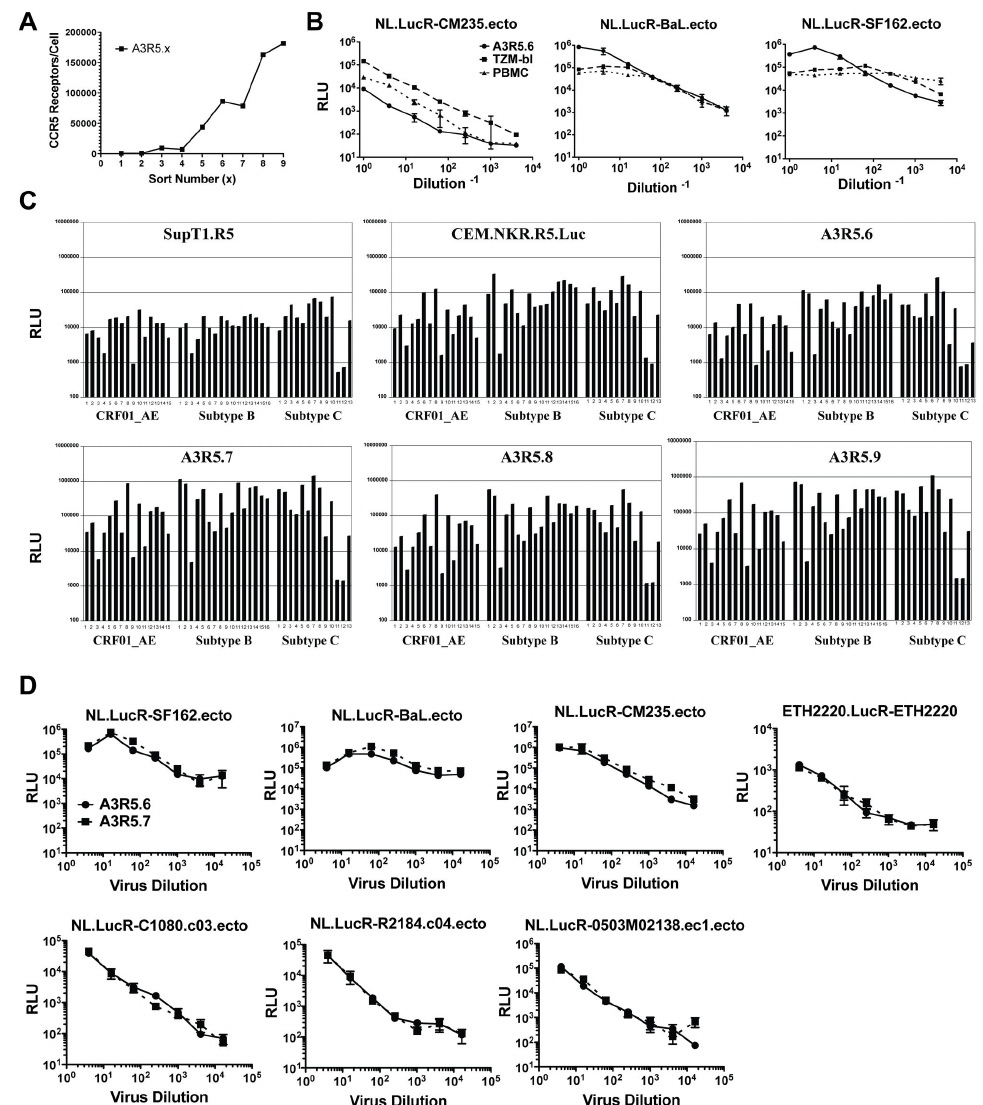
Figure 1. Initial characterization of A3R5 cell lines. A. CCR5 surface receptor number in sequentially sorted A3R5 cell lines. For each sort, 2.0 x 10 7 cells were subjected to fluorescence activated cell sorting with the brightest population (top 25%) selected for expansion. Receptor number was calculated using Simply Cellular Beads. In general, each successive sort resulted in increasing CCR5 intensity on the cell surface. B. Titration of NL.LucR-env.ecto in A3R5.6, TZM-bl and PHA/IL2 PBMC. Replication competent reporter viruses encoding subtype B env (NL-LucR.T2A-SF162.ecto, NL-LucR.T2A-BaL.ecto) and subtype AE env (NL-LucR.T2A-CM235.ecto) were titered in each target cell. Background luciferase activity (cell control wells) was subtracted prior to plotting. The data show similar virus growth in the three target cells. C. Infectivity of IMC.LucR viruses from multiple subtypes in various CCR5-expressing cell lines. IMC.LucR from subtypes B, A/E and C were screened at a 1:3 dilution in triplicate for their ability to infect four different sorts of A3R5 cells as well as the SupT1.CCR5 and CEM.NKR.CCR5.Luc cell lines. The average relative light unit (RLU) values are indicated. IMC described in Table S1. While all cell lines supported IMC.LucR replication, infection was determined to be optimal in the A3R5.7 cell line. D. Titration of IMC.LucR in A3R5.6 and A3R5.7 cells. CRF_01 AE Env IMC (CM235, C1080, 0503M02138 and R2184 with backbone: NL.LucR-env.ecto) and subtype C Env IMC (ETH2220.LucR-ETH2220) were titered in the presence of DEAE-Dextran. Virus replication was measured as relative luminescence units (RLUs). Background luciferase activity (cell control wells) was similar in both cell lines and subtracted prior to plotting. Data represents the mean of three replicates with standard error bars (SEM). The data indicate no significant difference in IMC.LucR growth between the A3R5.6 and A3R5.7 cell lines (paired t-test;p0.5). doi: 10.1371/journal.pone.0077756.g001 PLOS ONE |